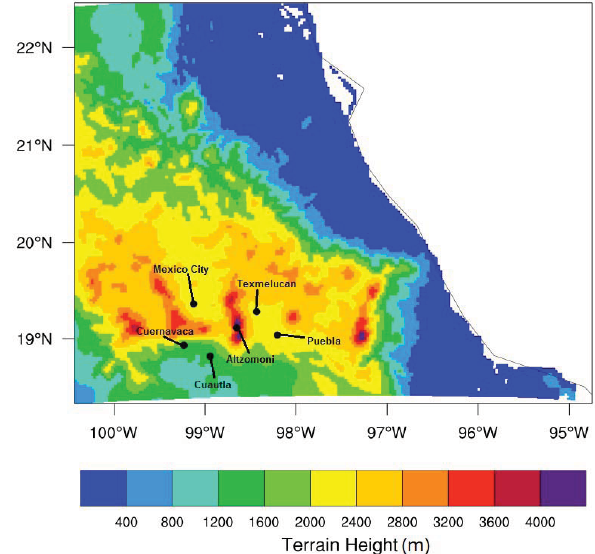
Figure 1. This diagram shows the inner domain used in the WRF-Chem model, at a resolution of 3 x 3 km. The color coding refers to elevation (m.a.s.l.). The Fig. 1. This diagram shows the inner domain used in the WRF- research site, Altzomoni, is shown along with the major cities that are sources of Chem model, at a resolution of 3 × 3km. The color coding refers to pollution. The areas of Mexico City, Cuautla, Cuernavaca, Puebla and Texmelucan are upwind of Altzomoni when air originates from the WNW, SW elevation (m.a.s.l.). The research site, Altzomoni, along with three and E, respectively. locations centered in regions of high anthropogenic pollution, are also shown. The areas of Mexico City, Cuautla and Texmelucan are upwind of Altzomoni when air originates from the WNW, SW and E,